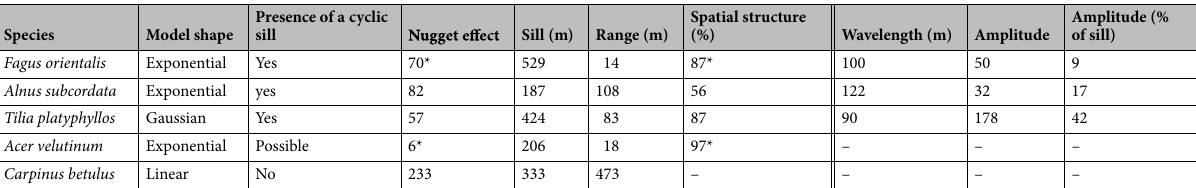
Table 3. Variogram characteristics for five tree species. Values typically assessed from variogram analysis for interpretation with respect to the landscape are the nugget, sill, range and spatial structure. However, the wavelength and amplitude of the variogram sill instead of a single average number are important in this study where the unusual cyclical sill patterns indicate a relationship between dbh and the topography. *Reflects values considered over-fitted by the automatically generated